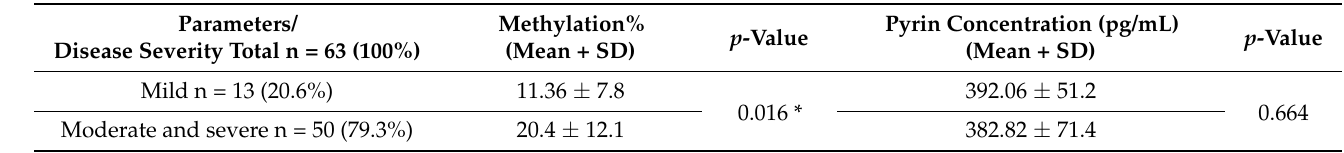
Table 4. Relation of MEFV exon 2 methylation% and pyrin concentration with disease severity among patients.